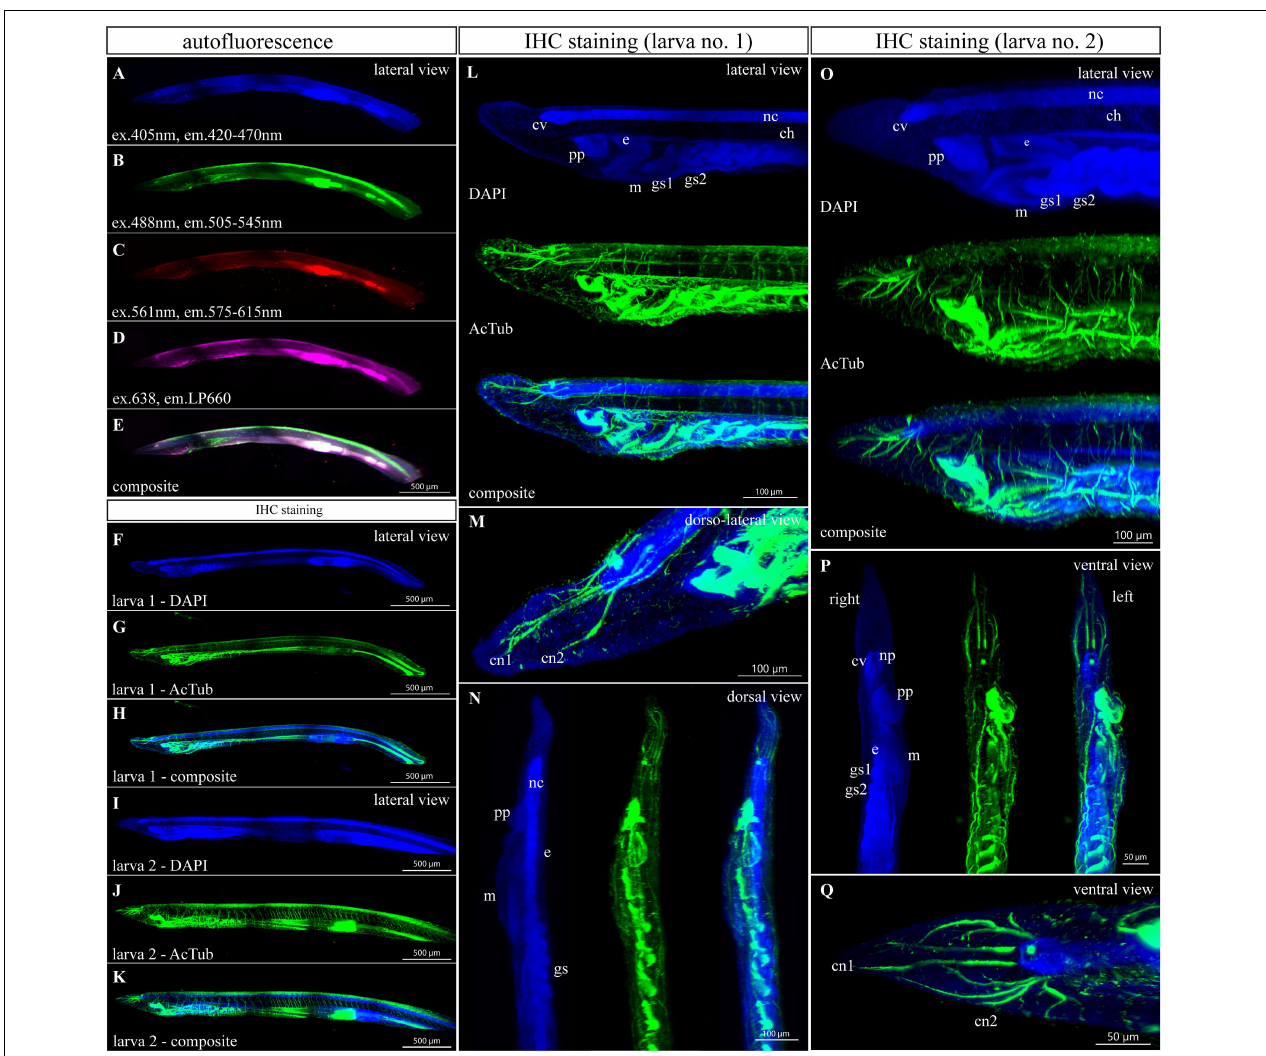
FIGURE 2 | Autofluorescence and anti-acetylated- α -tubulin staining of a 1-month-old amphioxus larva. (A–D) Individual scan of larva autofluorescence emitted in blue (A) , green (B) , red (C) , and magenta channels (D) . (E) Composite image of previous scans. The larva scanned for autofluorescence was about 2.9 mm long and had seven unpaired gill slits. (F–Q) Immunofluorescent staining of acetylated tubulin in 1-month-old larvae. (F–K) Whole-mount images of two different individuals. Larva 1 was about 2.7 mm long and had seven unpaired gill slits. Larva 2 was about 3.5 mm long and had eight unpaired gill slits. (L) Detail of the anterior portion of larva 1 from the left side view. (M) Detail of cranial nerves of larva 1 from the dorsolateral view. (N) Detail of the anterior portion of larva 1 from the dorsal view. (O) Detail of the anterior portion of larva 2 from the left view. (P) Detail of the anterior portion of larva 2 from the ventral view. (Q) Detail of cranial nerves and a cerebral vesicle of larva 2 from the ventral view. Larvae 1 and 2 came from the same batch and were raised in the same conditions. All fluorescence images represent 3D reconstruction of the whole body mass. The regular areas of low signal intensity are caused by lower intensity of light falling on the camera